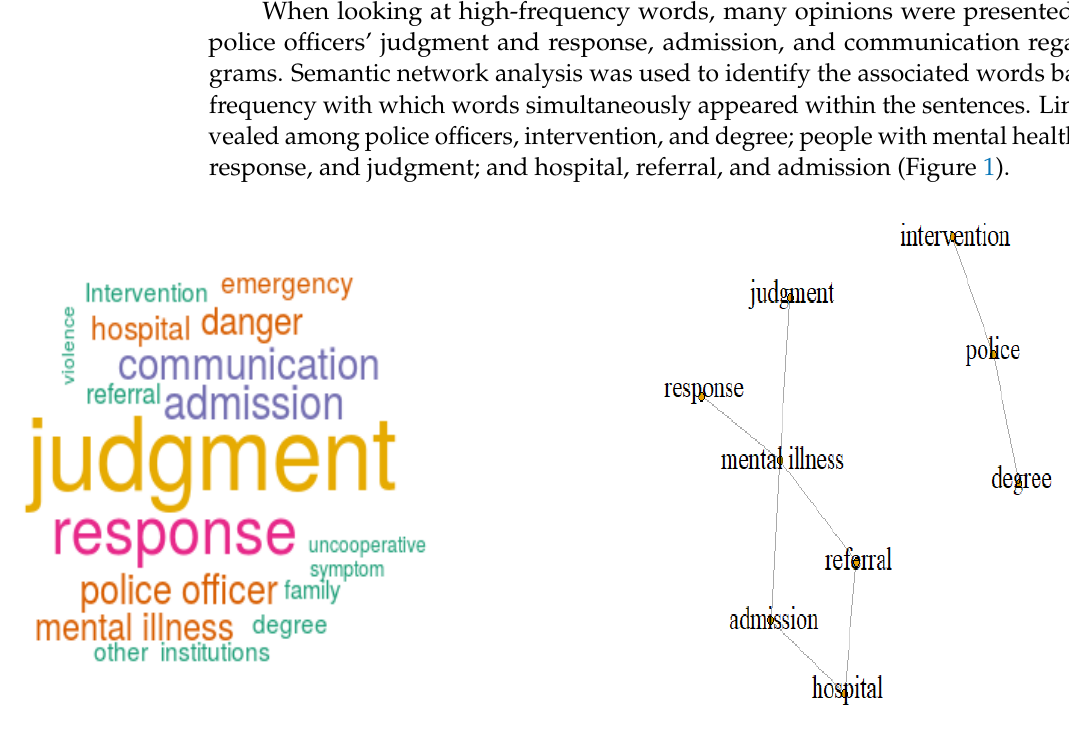
Figure 1. Word cloud analysis regarding the most preferred requirements.